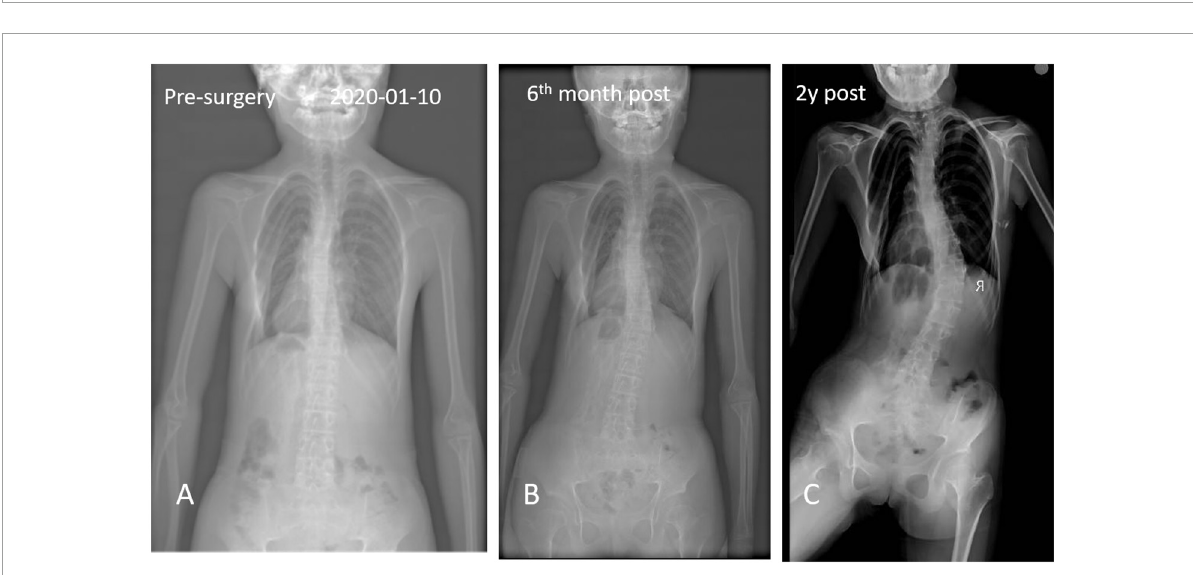
FIGURE4 Anteroposterior and axial x-ray radiographic evaluation showed a massive radiopaque formation located predominantly in the region of back and spinal